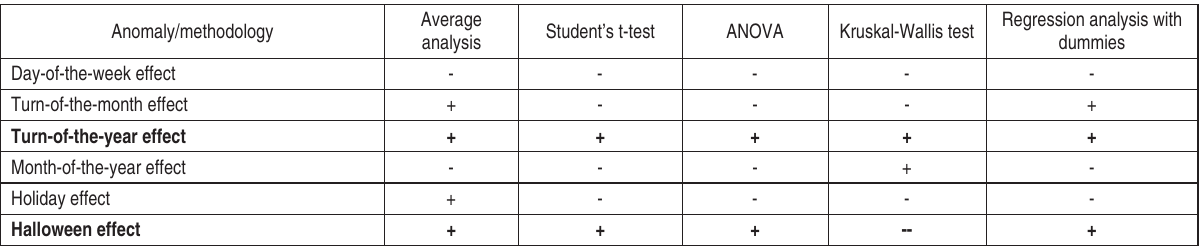
Table 1, 2 and 3 below summarize the results. Table 1. Overall results for PFTS index